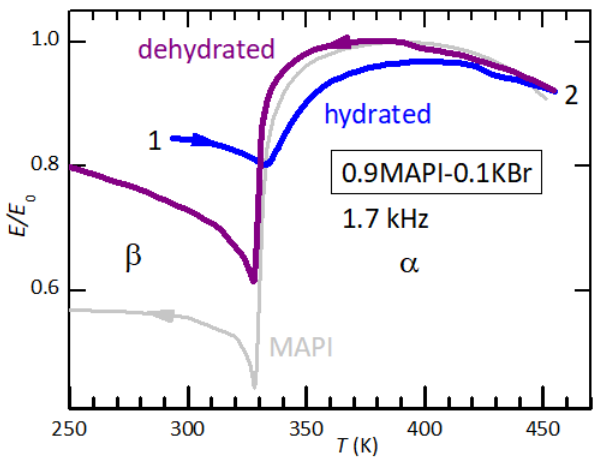
Figure 6. Young’s modulus of 0.9MAPI-0.1KBr measured in high vacuum in an initially hydrated condition. As for pure MAPI, the softening in the β phase is initially smaller (curve 1) than after dehydration (curve 2). With respect to pure MAPI (gray line), the amplitude of the step at the α / β transition in dehydrated condition is smaller, due to the fraction of inert